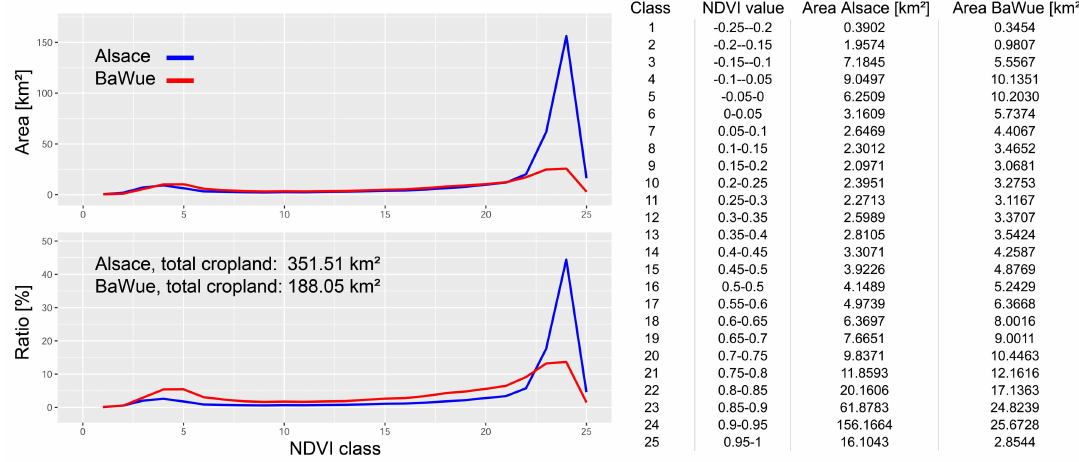
Figure 7. Distribution of NDVI values in the study area plotted from the Sentinel-2 test data (18 August 2019). The total cropland area in the Alsace (3,515,079 km²) and in Baden-Württemberg (1,880,467 km²) is split into 25 NDVI classes ranging from −0.25–1. Both parts of the URA behave equally in spatial differentiation until NDVI class 20/21 where the Alsace begins to show increased spatial distribution of high NDVI values. The ratio (percent of total cropland) also increases, which excludes a mere spatial component of the value differences between the Alsace and BaWue.